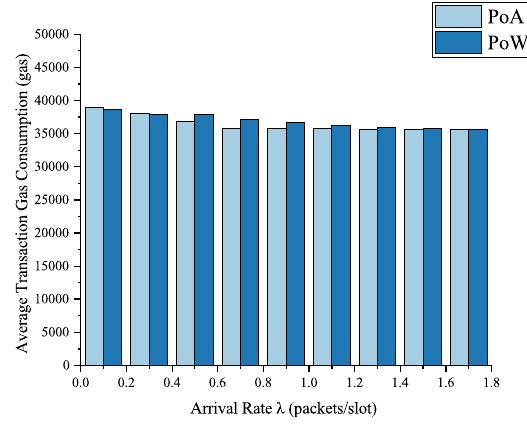
Figure 9. Average transaction consumption of PoA and PoW blockchain